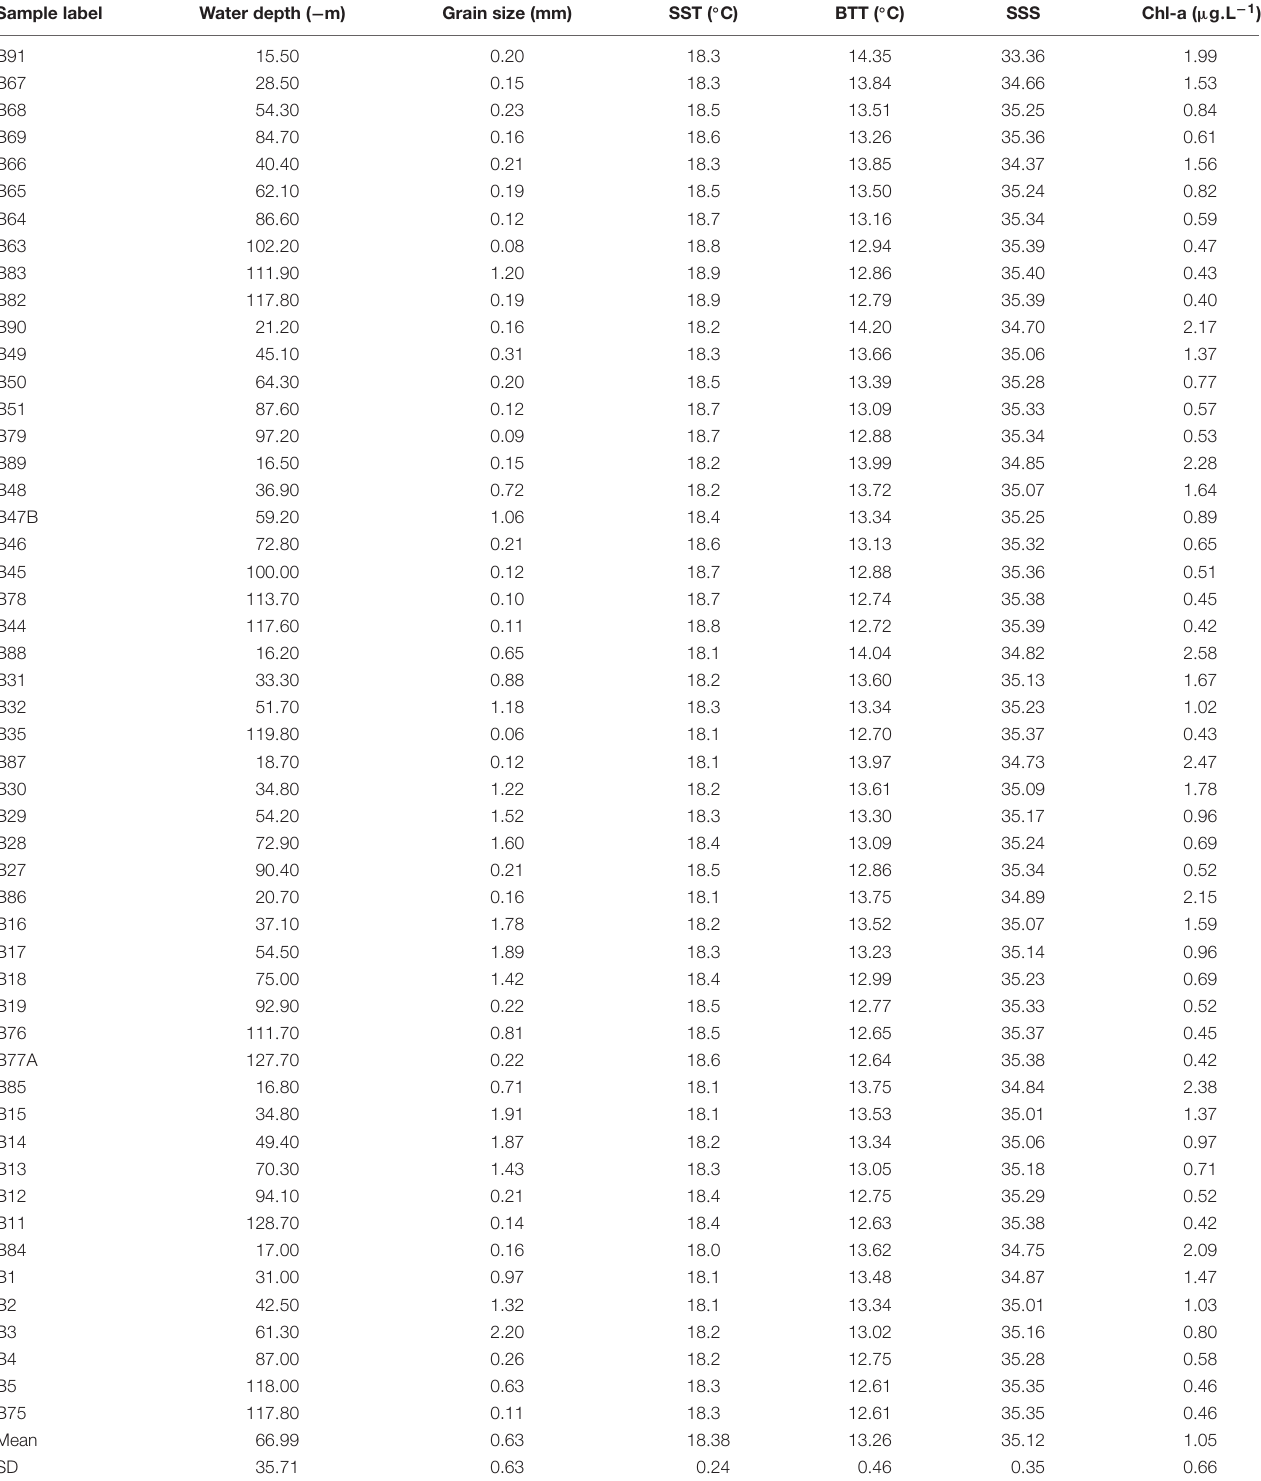
TABLE 1 | Samples studied in this paper and the six environmental parameters included in statistical analyses. Sample